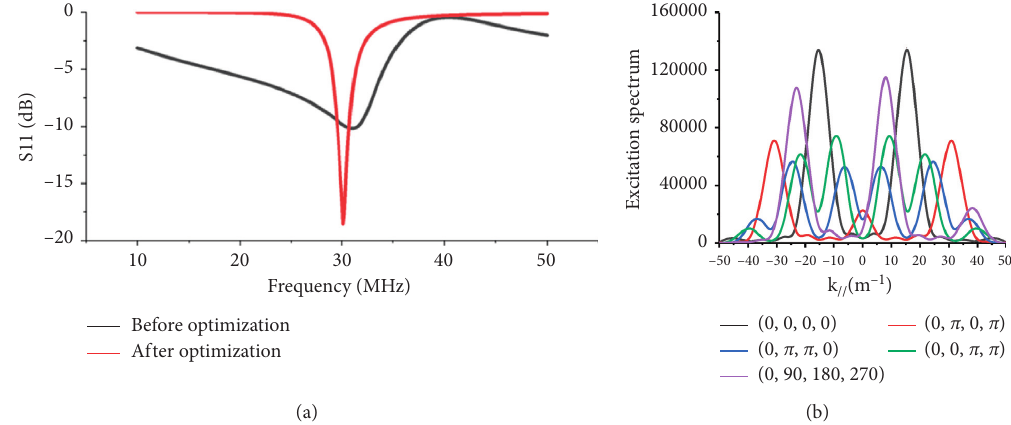
Figure 9: S11 comparison of the two versions of the antenna (a) and k